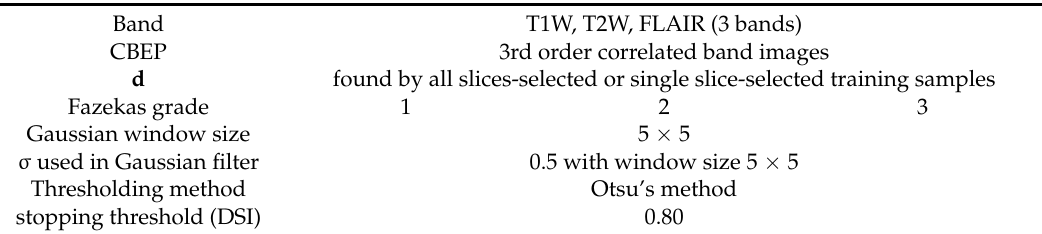
Table 4. Parameters used by CBEP-ICEM2.